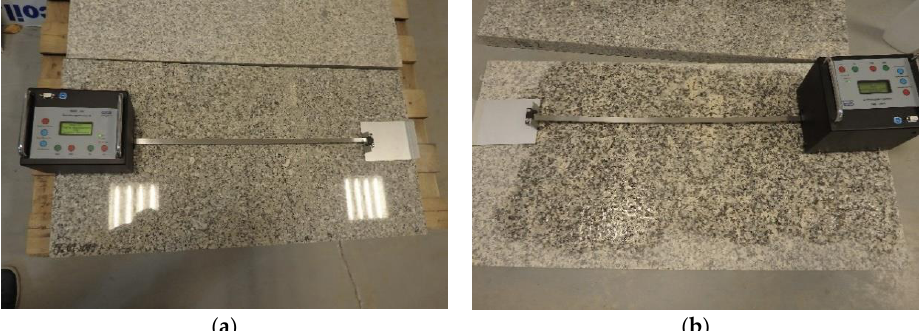
Figure 7. Dynamic coefficient of friction measurement: ( a ) PO series in dry condition, ( b ) flamed (PL) series in wet condition.